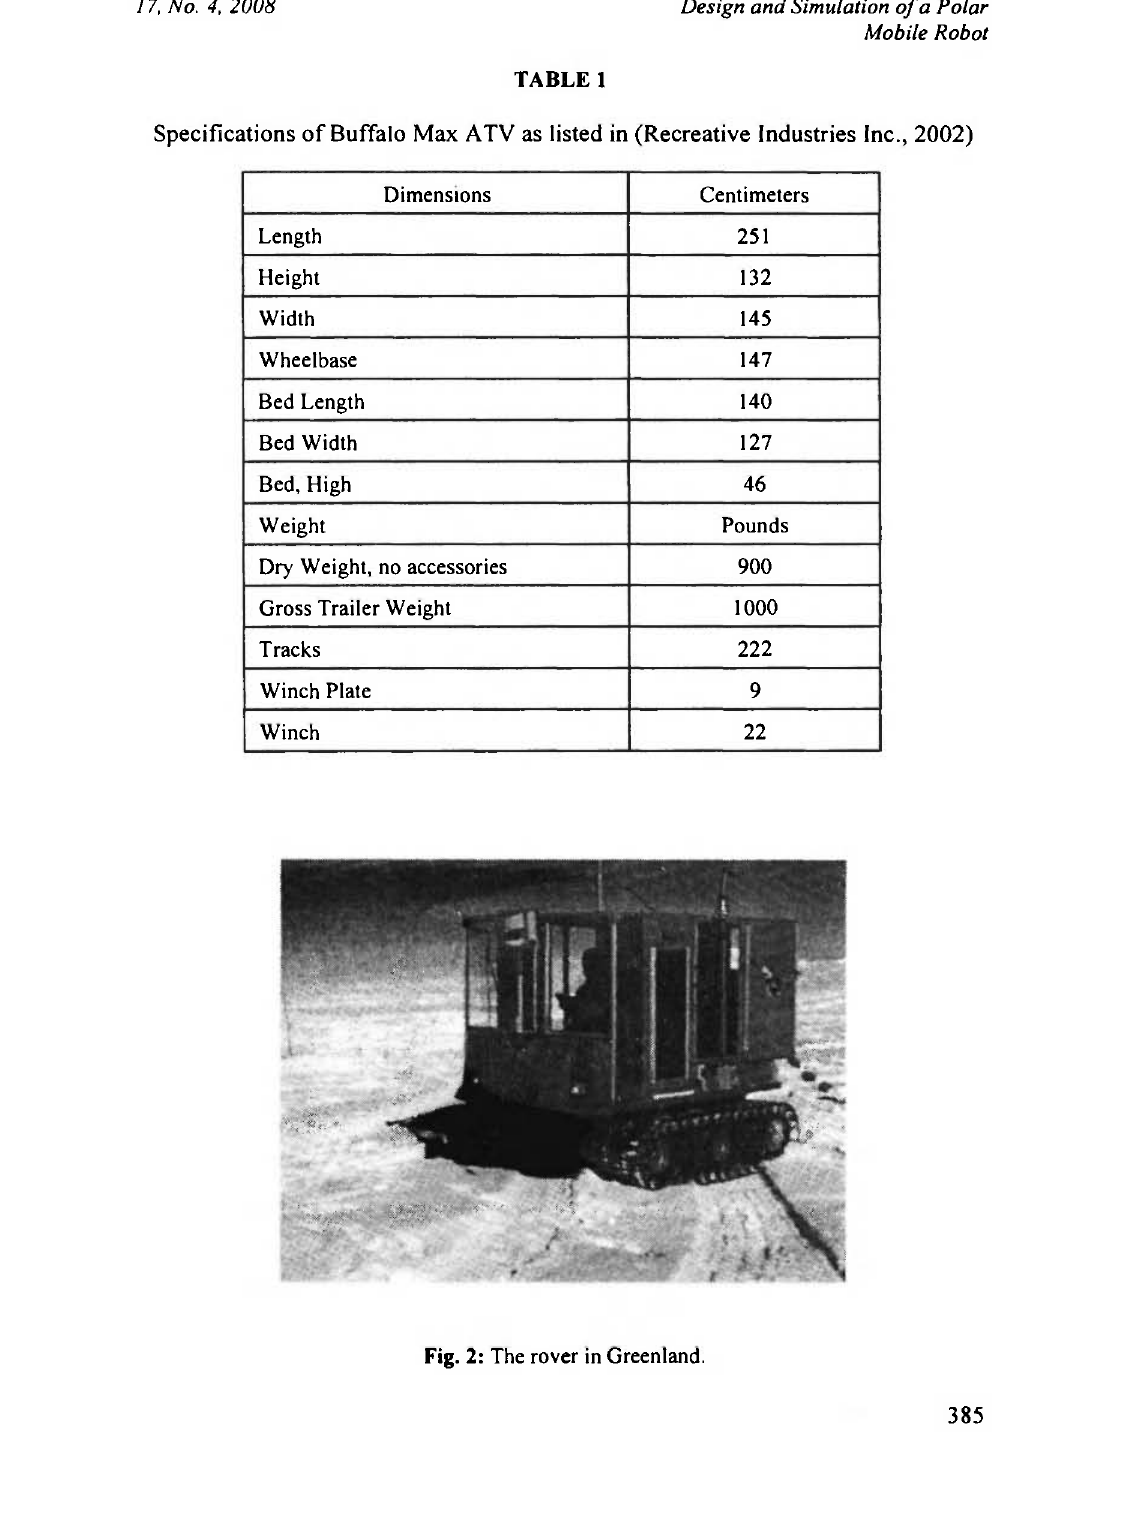
Fig. 2: The rover in